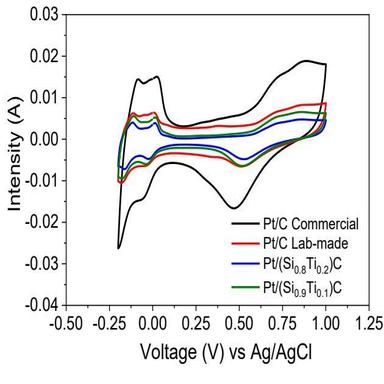
Cyclic voltammograms for the different catalysts. Conditions: 20 C, 1 M H2SO4 (inertized with N2), 50 mV s-1 vs RHE. Cycle 50.